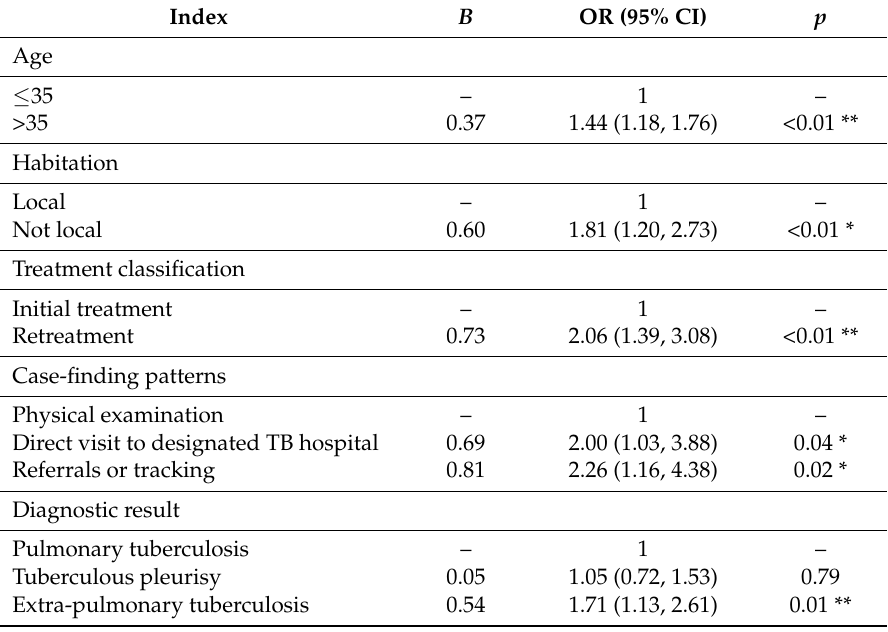
Table 2. Multivariable logistic regression analysis of case-finding delays among full-time teachers with